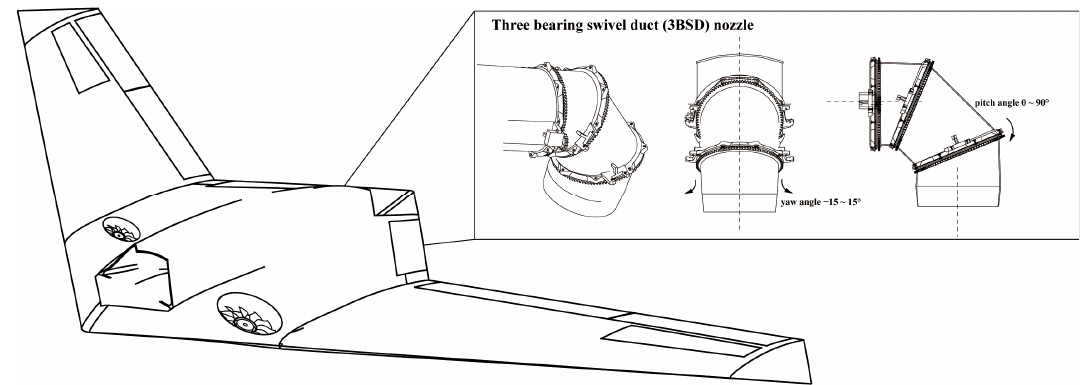
Figure 1. General diagram of the configuration of the subject flyingwing UAV.